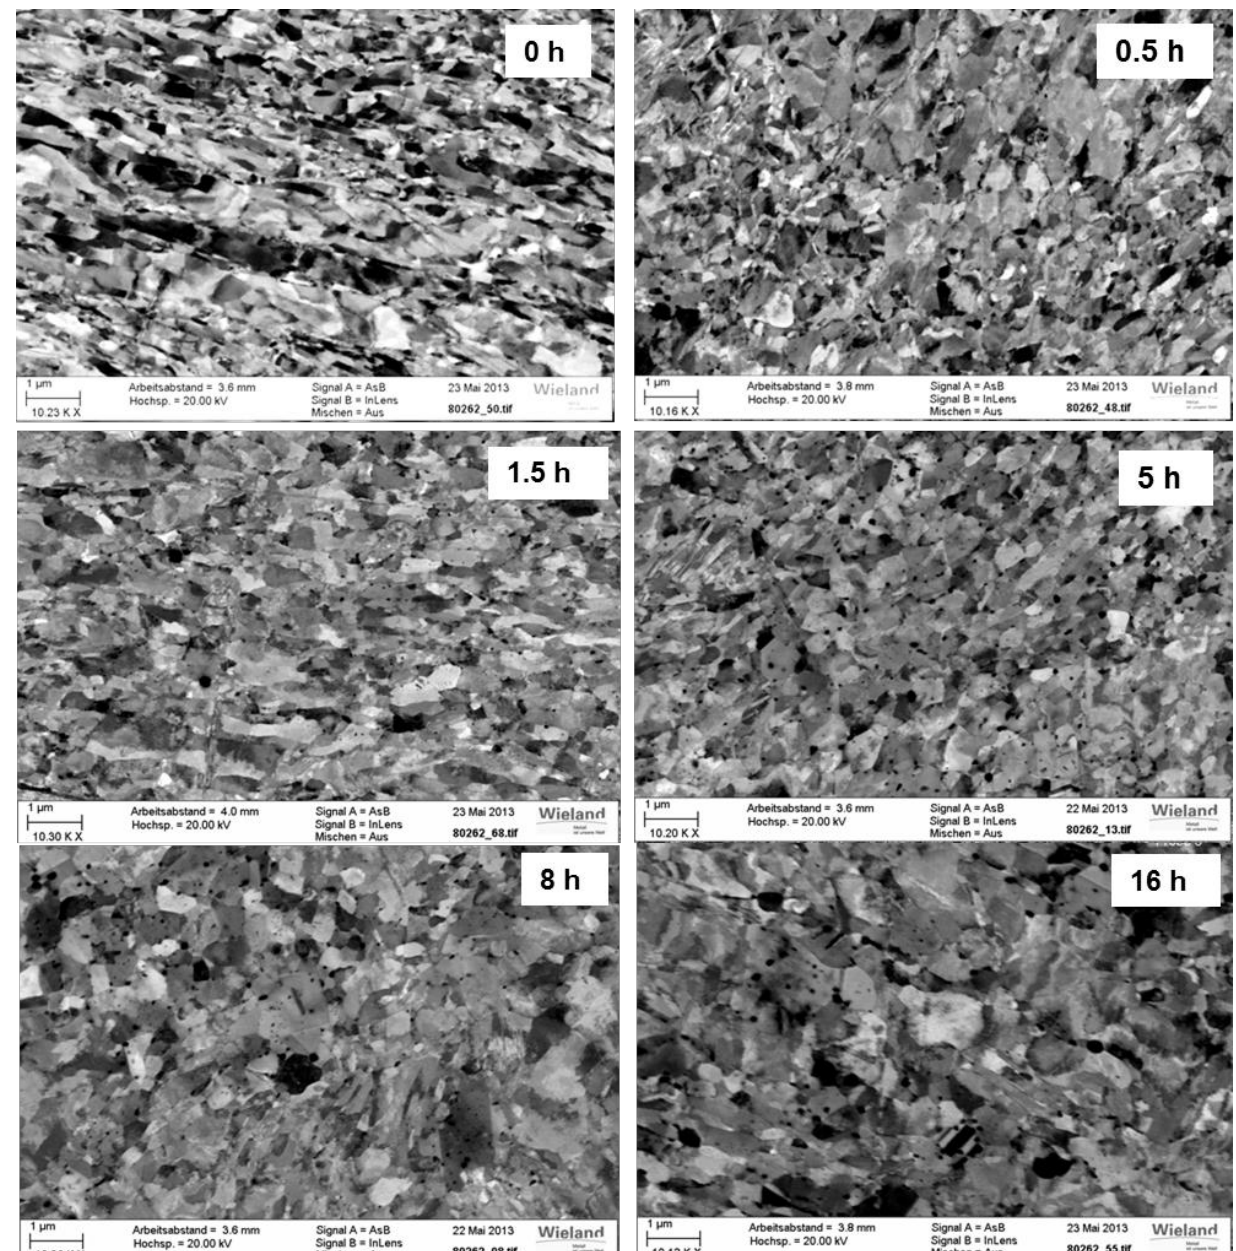
Figure 3. Microstructure of swaged CuNi3Si1Mg after different aging times ( T = 450 °C)